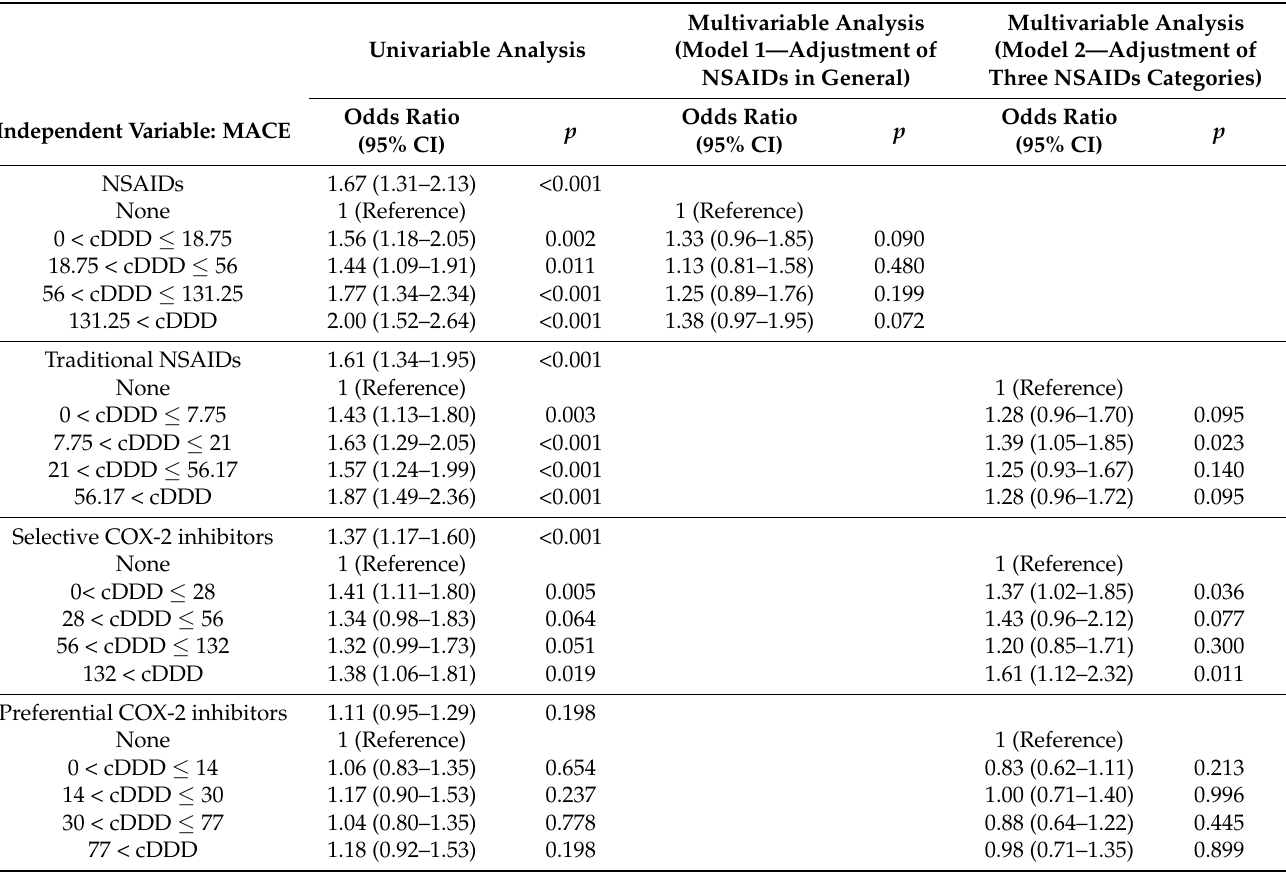
Table 3. Associations between annual cumulative dosage of NSAIDs and MACE in patients with ankylosing spondylitis. Multivariable Analysis Multivariable Analysis Univariable Analysis (Model 1—Adjustment of (Model 2—Adjustment of NSAIDs in General) Three NSAIDs